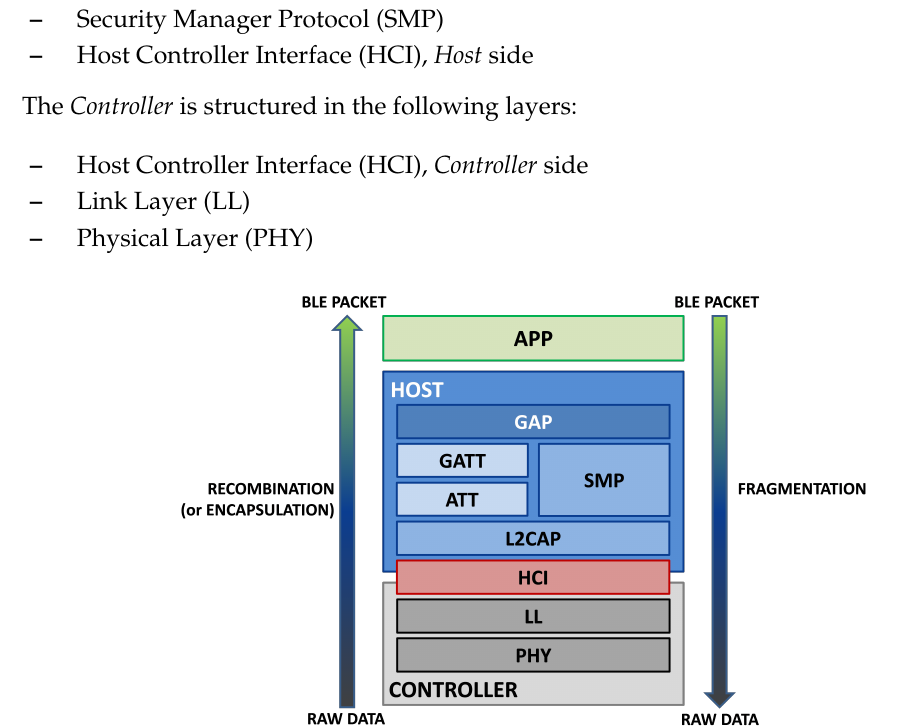
Figure 1. BLE protocol stack. The three main blocks are the Controller (grey), the Host (blue) and the App (green). The HCI (red) is the interface that manages the communication between the Controller and the Host . The rectangular frames represent the different layers of the protocol, and they are ordered in a stack, which starts from the bottom, with the PHY part, and ends at the higher level, that is the App . The arrows show how encapsulation and fragmentation work. Adapted from